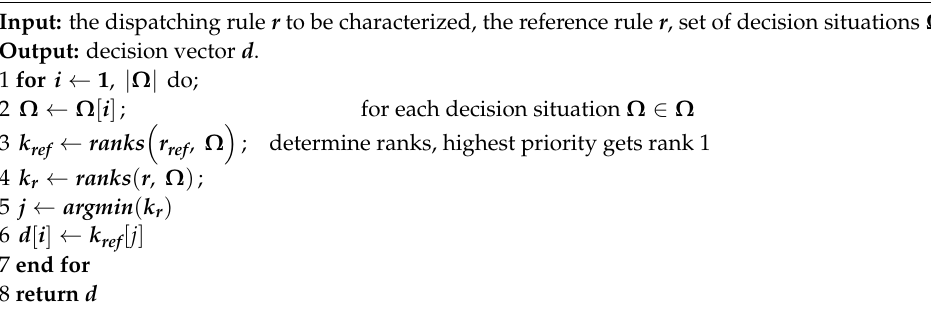
Algorithm 2. Compute the phenotypic characterizationof dispatching